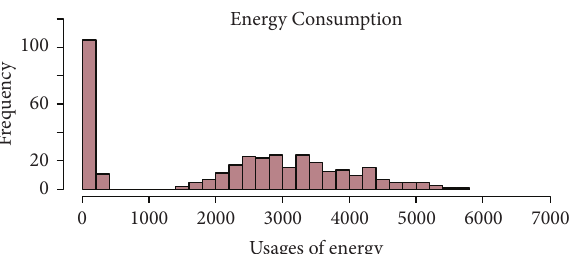
Figure 5: A histogram illustrating appliance energy usage allocation. The graph depicts the interval’s frequency (bar width) of energy